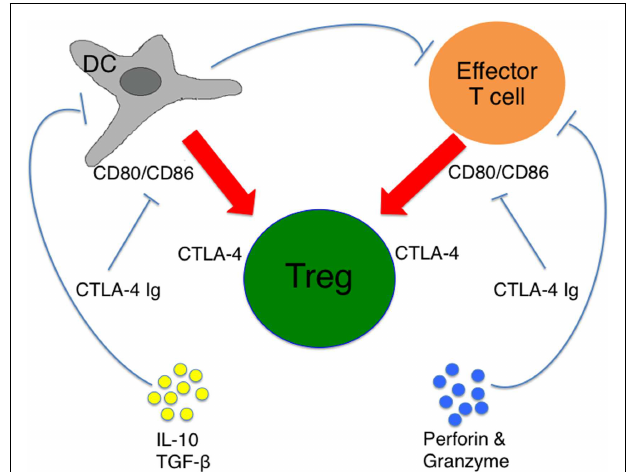
FIGURE 1 | Suppressive mechanisms ofTreg cells .Treg cells mediate their suppressive activity by direct cell–cell contact mediated by CTLA-4 on bothTeffs and APCs, e.g., DCs. Suppressive cytokines (IL-10 andTGF- β ) suppresses DC maturation and function.Treg cells also destroyTeffs through secreting perforin and